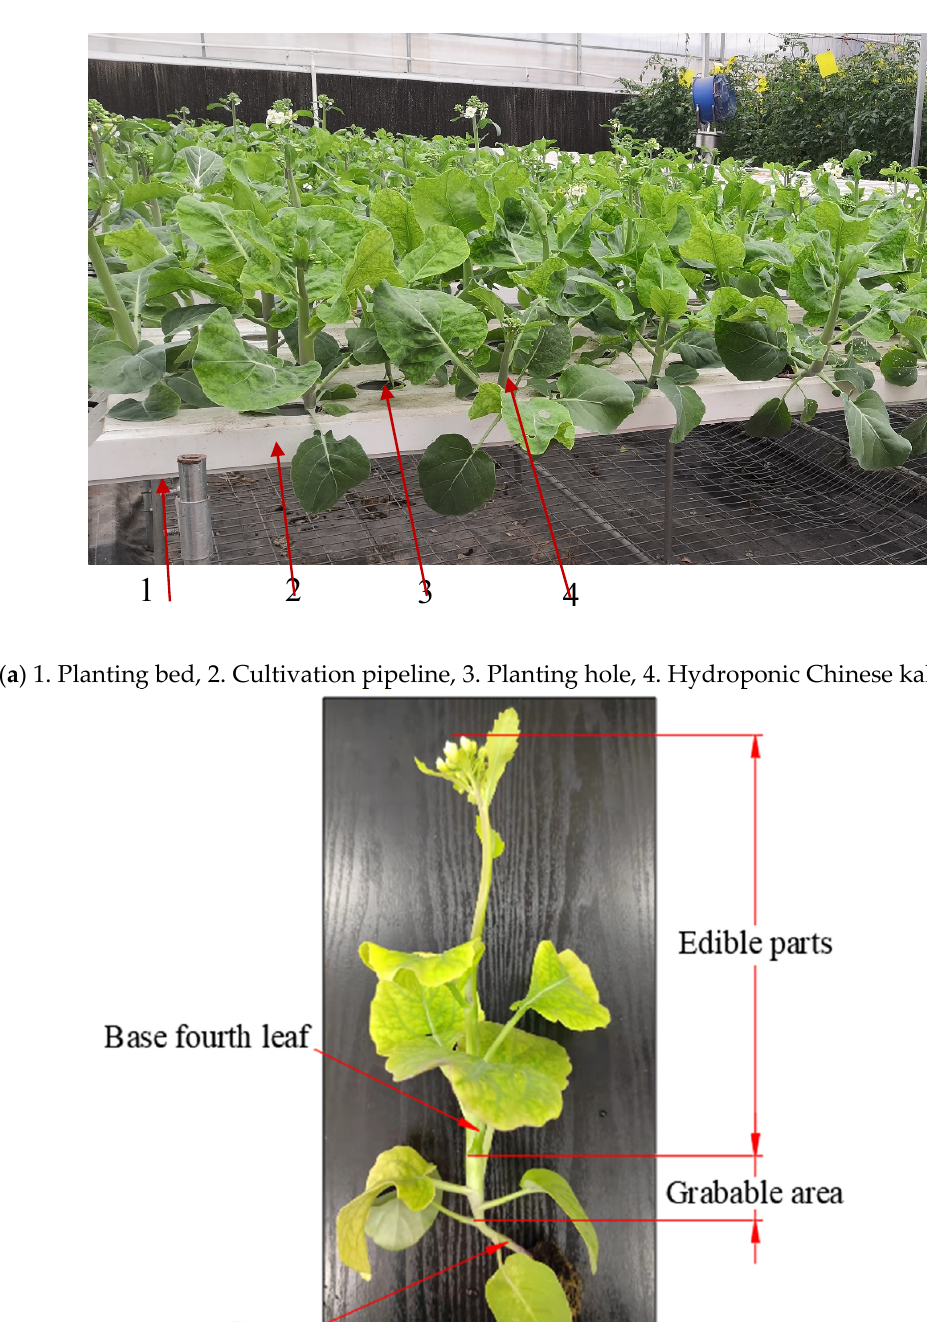
500 mm; accuracy: 0.05 mm) was selected to measure the area height. A high-precision electronic scale (range: 1000 g; accuracy: 0.01 g) was utilized to measure the total mass of the hydroponic Chinese kale. The statistical results are shown in Table